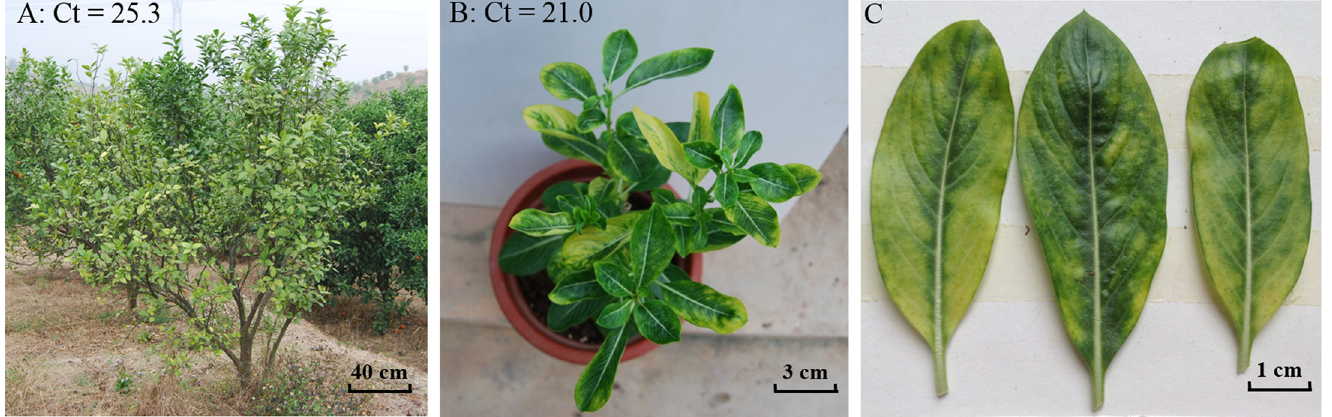
Fig 1. “ Candidatus Liberibacter asiaticus ” strain A4 in two plant hosts in Guangdong, China. (A) A Huanglongbing (HLB) symptomatic tree of Citrus reticulata cultivar “ Shatangju ” in Sihui City, Guangdong, China. (B) Symptomatic periwinkle plant infected by “ Ca . L. asiaticus ” via dodder transmission from citrus. The CLas strain was designated as A4 and maintained and propagated in a screenhouse through grafting. (C) Symptomatic periwinkle leaves used to extract DNA for genomic study. Increase of “ Ca . L. asiaticus ” titer from citrus to periwinkle is indicated by the decrease of Ct values using the PCR procedure described by Li et al.